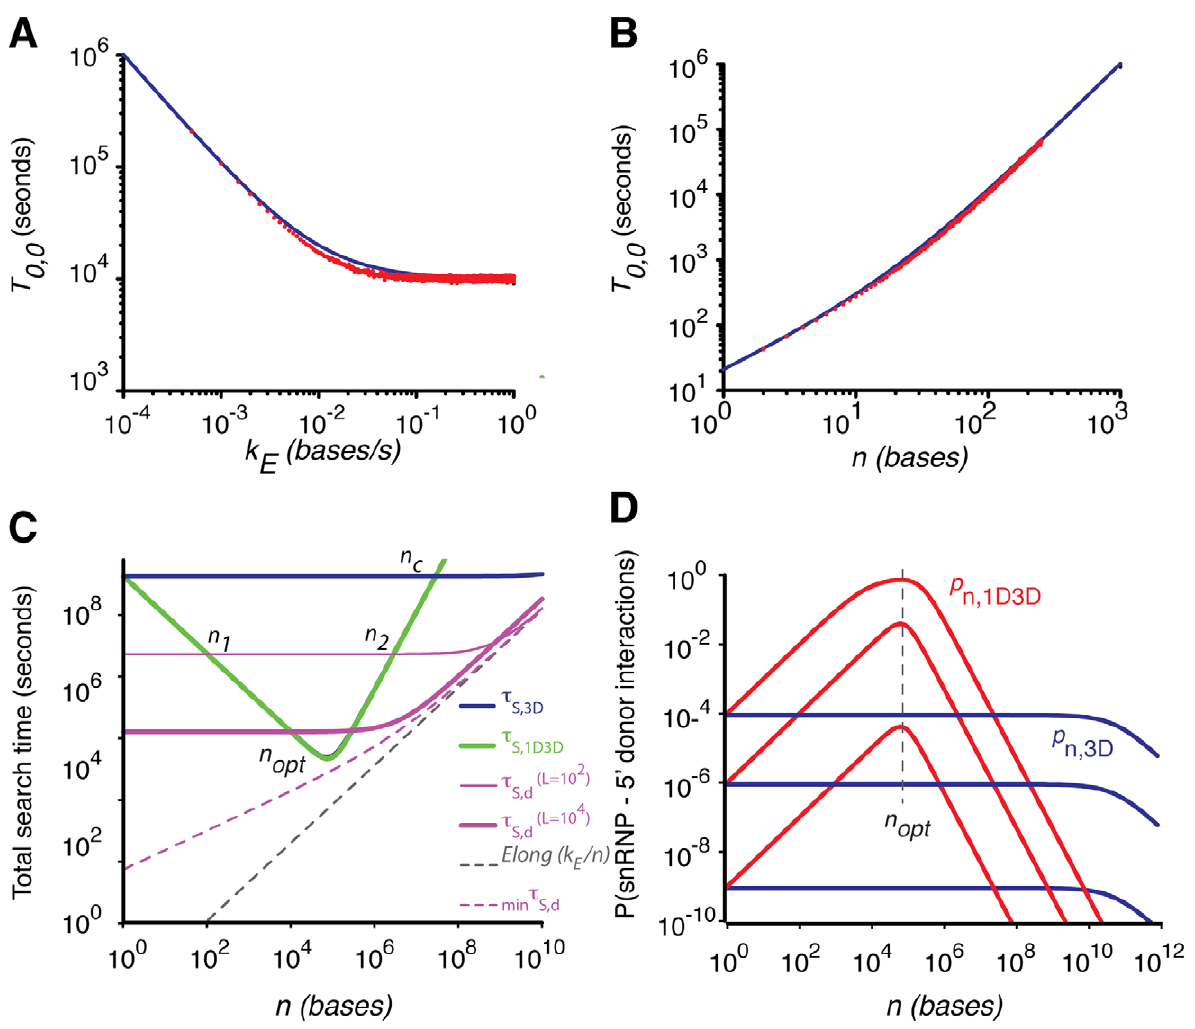
Figure 2. A–B. Validation of the expression for the mean first passage time (MFPT, in seconds) given by Eq. 4 (blue) using random walk simulations (red) at different elongation rates k E (A) and different positions of the absorbing boundary n (B). Initial positions: x 0 =0 (snRNP) and y 0 =0 (RNAPII). x d =1 bases 2 /s. In A , n =100 bases and in B , k E =1 base/s. Whenever the random walker (snRNP) hits the drifting reflecting boundary x=y , it is put back into the interval (0, y ). Whenever y=n and x=y the random walker is removed from the system. The MFPT was calculated over 10 5 random walk trajectories (Materials and Methods). C. Minimization of the overall search time by an snRNP to locate the splicing site DSS n on the pre-mRNA when the search is via 3D only ( t S,3D , blue, Eq. 7 ), 1D + 3D routes ( t S,1D3D , green, Eq. 5 ) or 1D + 3D including snRNP dissociation ( t S,d , pink, Eq. 9 , shown for two different values of the dissociation length L). There exists an optimum position of splice sites at around n opt =4 6 10 4 bases at which the 1D + 3D search time is minimized. The time taken for a pure 3D search will be less than the combination of 1D and 3D search beyond n c , 2 6 10 7 bases. The dashed black line indicates the transcription time ( k E /n ) and the pink dashed line indicates the minimum search time ( min t S,d , Eq. 10 ). Here the parameters are x d ~ 8 | 10 5 bases 2 /s, k E =72 bases/s and t t ~ 10 9 bases s. With a total of N 0 ~ 10 8 snRNPs and d o ~ 4 | 10 3 splicing-sites at a given active region of the nucleoplasm ( , 1% of the total nascent pre-mRNAs) the search time scales down by a factor of ( d 0 /N 0 ). D. Variation of the overall probabilities associated with the interaction of snRNPs with DSS n as a function of n for different snRNP concentrations ( N 0 =10 3 , 10 5 and 10 7 from bottom to top) ( Eqns 11–12 ). The red curves show the probabilities including 1D and 3D search mechanisms ( p n,1D3D , Eq. 11 ) and the blue curves show the probabilities including only 3D search mechanisms ( p n,3D , Eq. 12 ). p n,1D3D reaches a maximum at the value n opt , which does not depend on N 0 . As N 0 increases, the optimum position of splicing sites on the pre-mRNA expands into a wider range of n values. Here the parameter settings were k off,n =10 s 2 1 and other parameters as in part C .